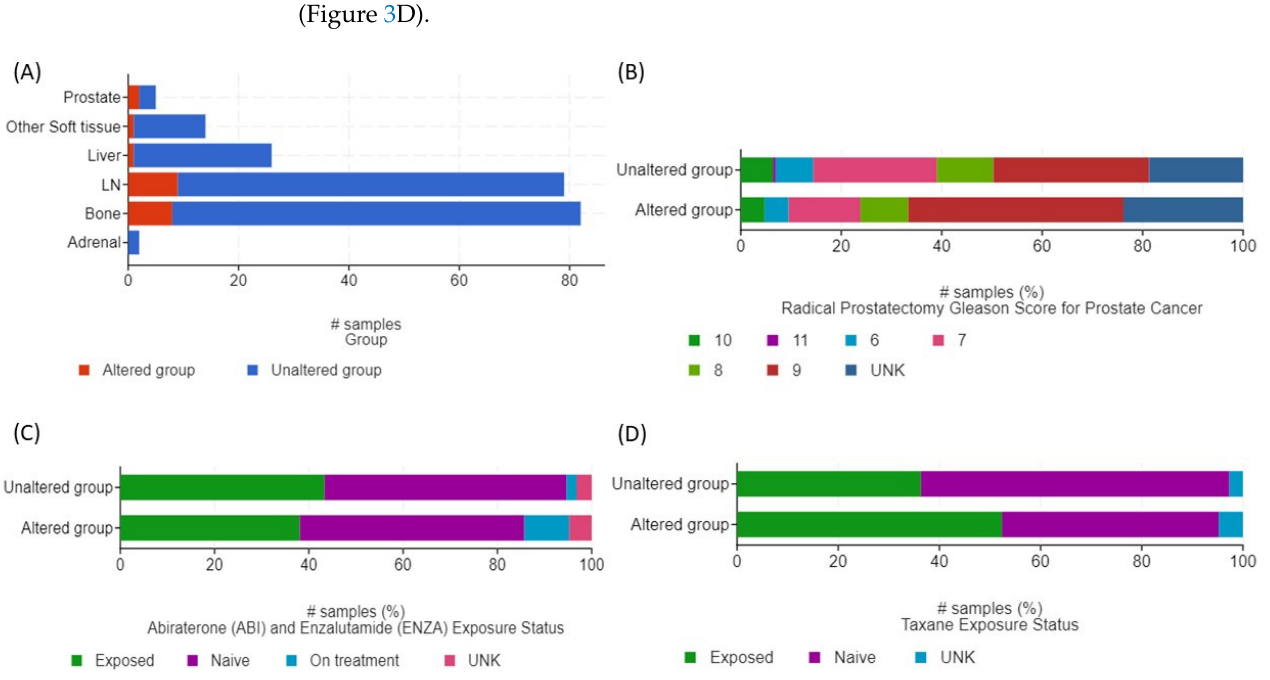
Figure 2. Copy-number alterations associated with high FAP mRNA expression in mCRPC patients.